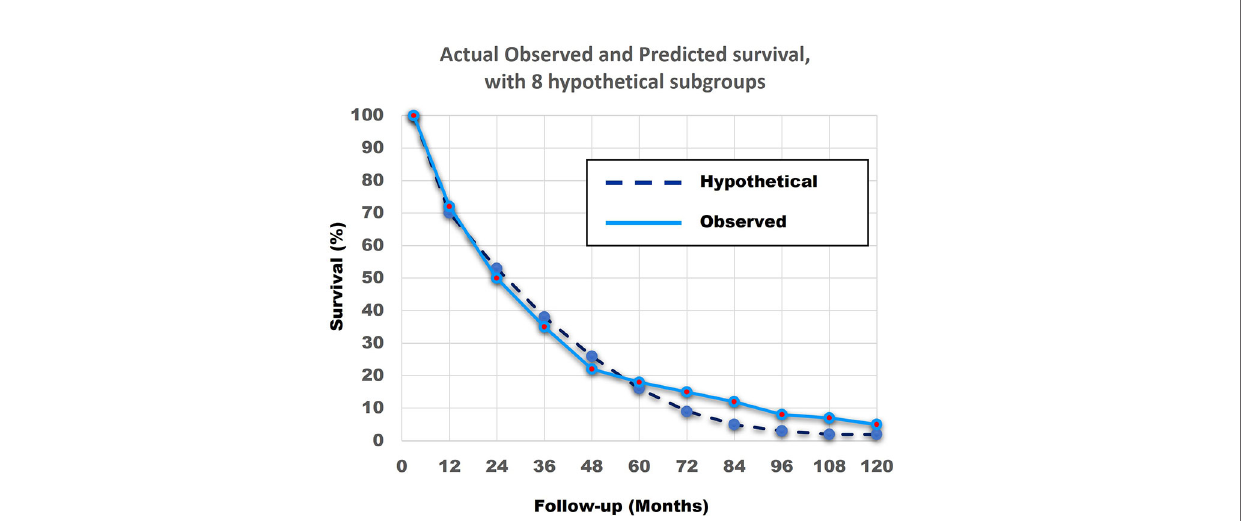
FIGURE 12 | The actual observed survival curve (light blue continuous line) with the results of the combination of the model with 8 hypothetical straight lines (dark blue broken line). The similarity between the Actual Observed survival curve and the Hypothetical Calculated survival curve from the 8 hypothetical subgroups, with the linear survival curves from Figure 11 , is